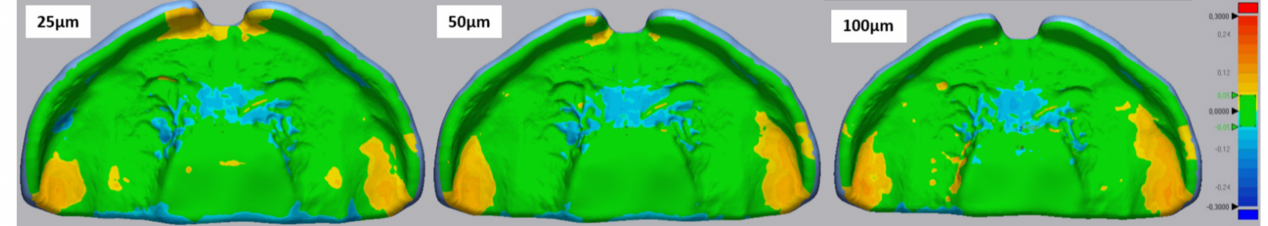
Figure 11. Exemplary files of trueness colour maps for the different DLP layer thicknesses (25 µ m, 50 µ m and 100 µ m). The colour maps display a critical deviation of ± 300 µ m and a nominal deviation of ± 50 µ m.